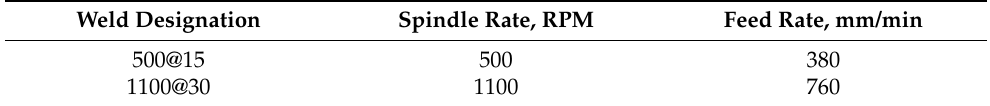
Table 2. Parameters of the FSW process used in this